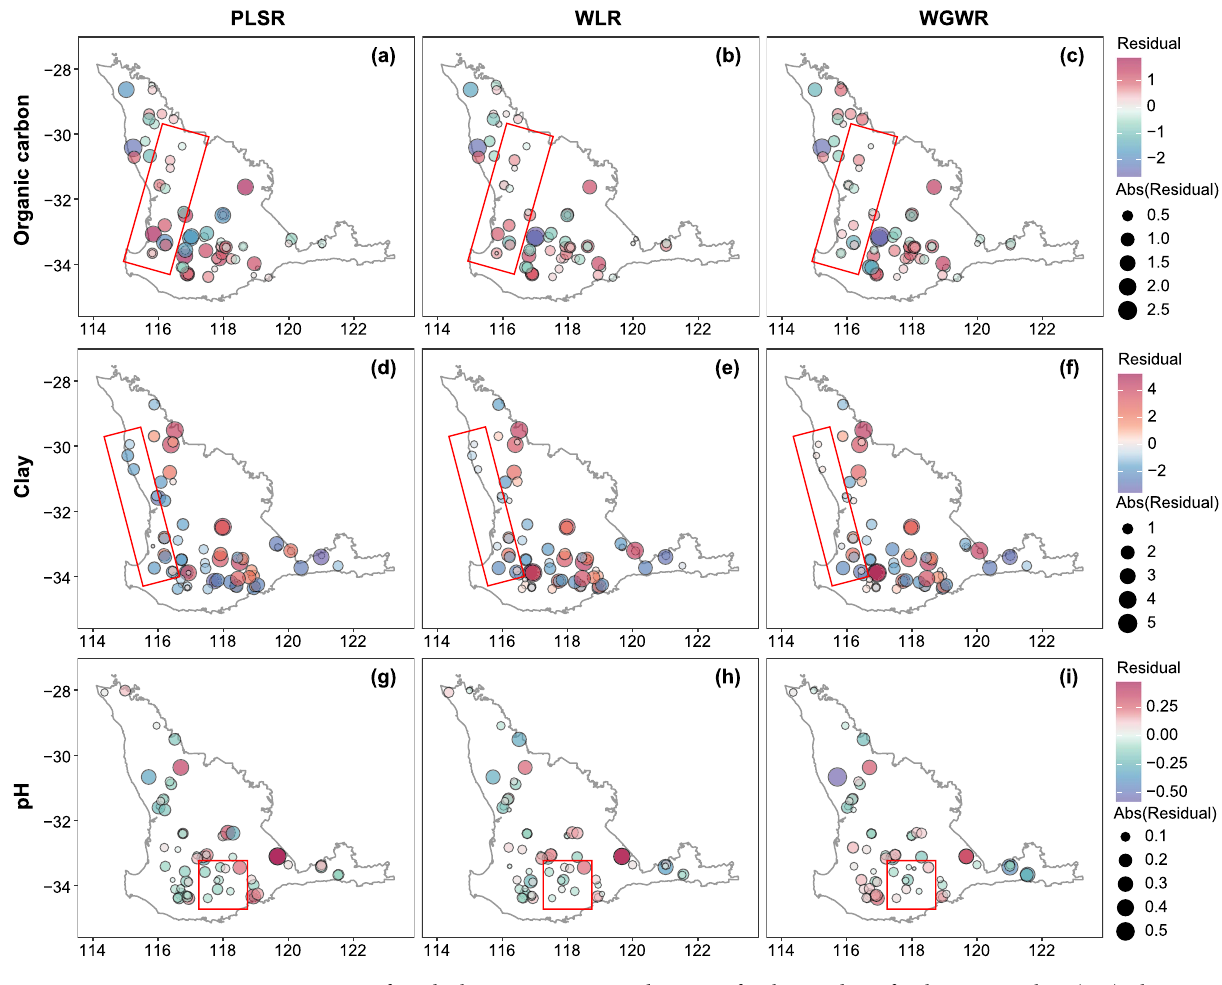
Figure 6. Maps of residuals in PLSR, WLR, and WGWR for the test data of soil organic carbon ( a – c ), clay ( d – f ), and pH values ( g – i ). Regions marked with a red rectangular outline demonstrate the difference of the models and the accuracy of the estimates.